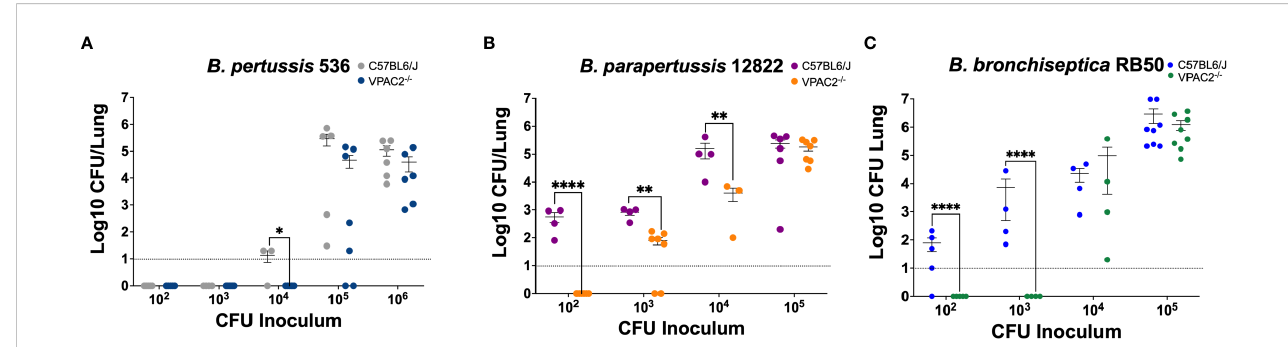
FIGURE 3 Functional VIP/VPAC2 axis promotes lung colonization by Bordetella spp. C57BL/6J and VPAC2 -/- mice were intranasally challenged with increasing bacterial inoculums (x-axis) of B. pertussis BP536 (A) , B. parapertussis 12822 (B) , and B. bronchiseptica RB50 (C) , each mouse strain indicated in the fi gure legends. At day 7 post-infection, we enumerated colonies from the lungs to evaluate colonization. Inoculations were done in parallel in the two different mice strains, and critical dosages were repeated in at least two independent experiments. Two-way ANOVA analysis was performed to evaluate statistical differences. The bars represent the mean ± SD, with each data point representing one mouse (n = 4-8 mice per condition). *p ≤ 0.05, **p ≤ 0.01, ****p <